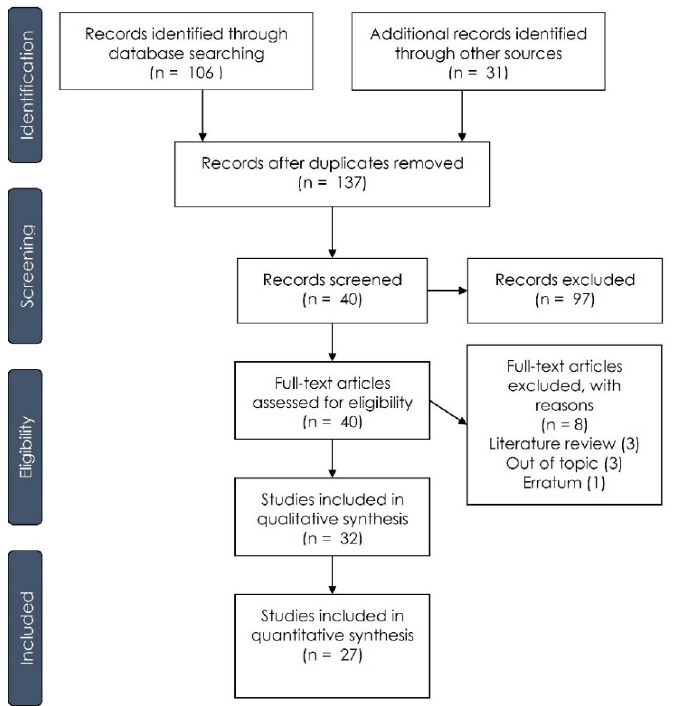
Figure 1. Summary of the manuscript selection process according to the “Preferred Reporting Items for Systematic Reviews and Meta-Analyses” (PRISMA)